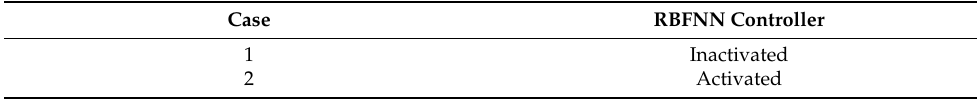
Table 2. Reactive power controller setting.